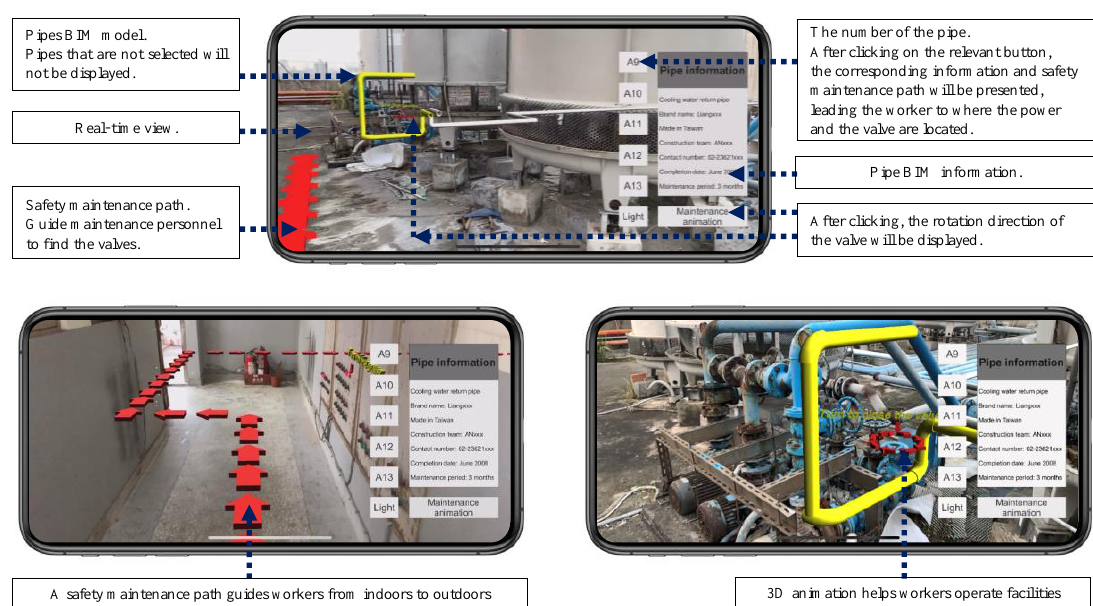
Figure 3. User interface of BARMS.